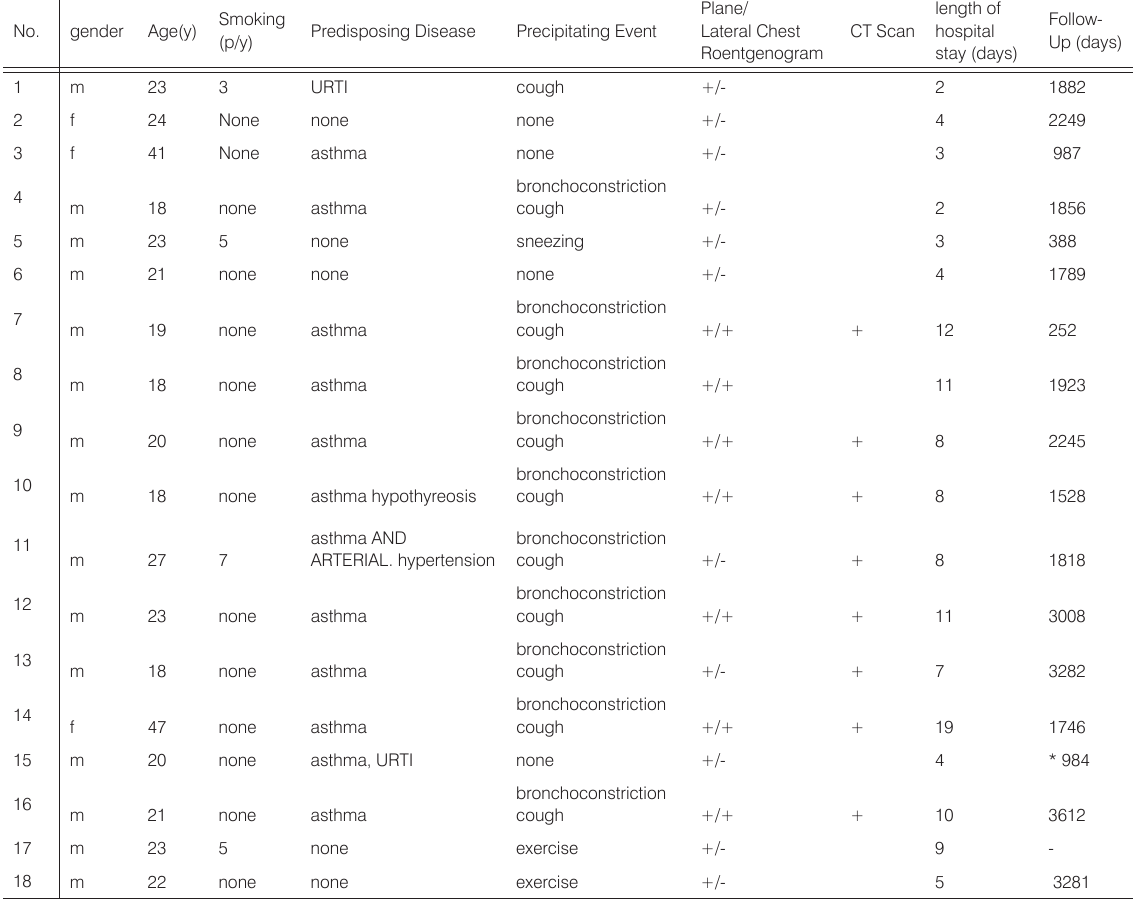
Table 1. Patient’s Demography, Predisposing and Precipitating Factors, Radiology Performed and Follow-Up Smoking No. gender Age(y) (p/y)